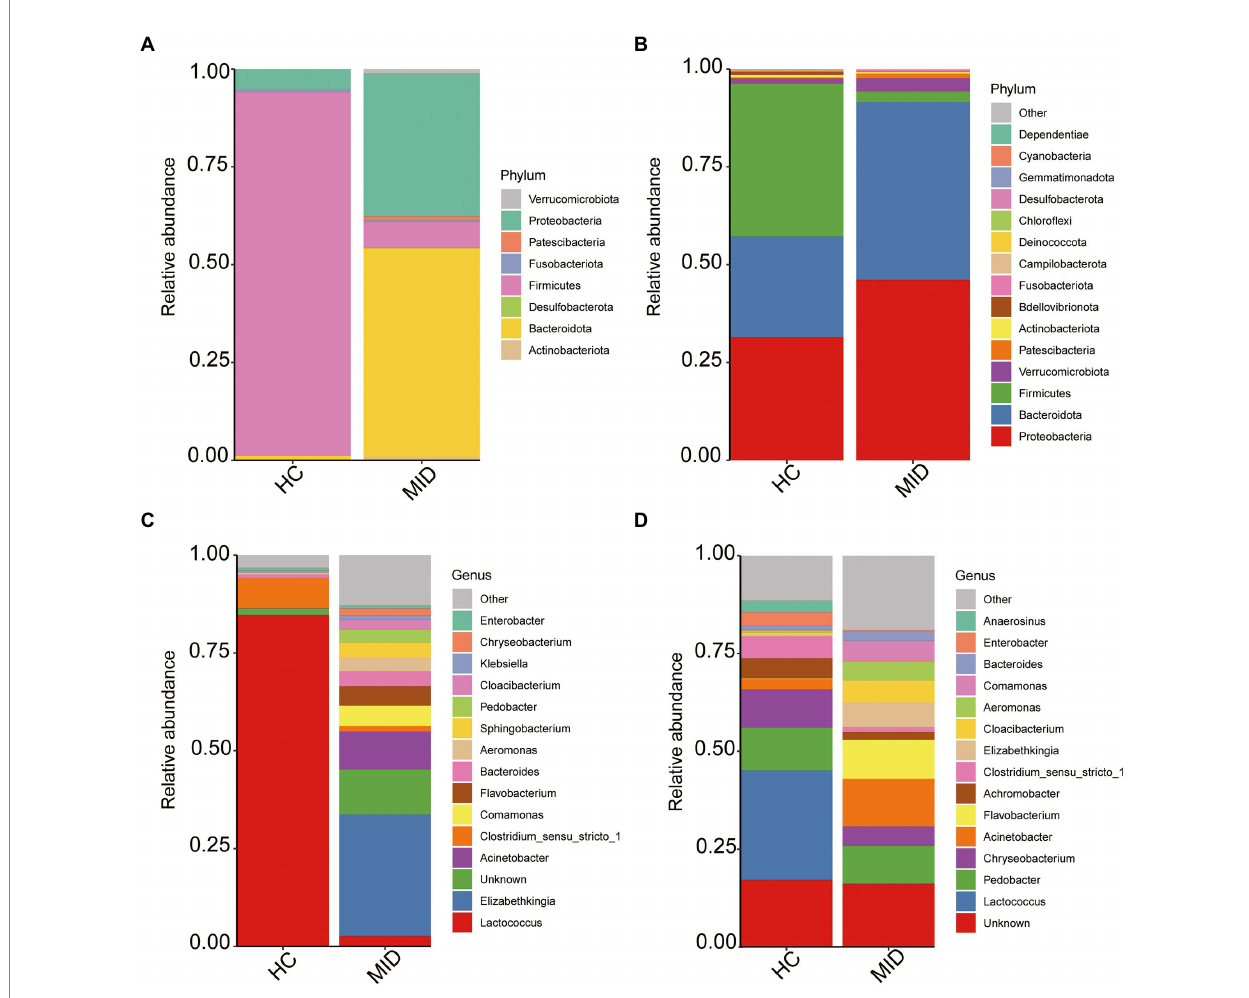
FIGURE 4 Average relative abundance of phylum and gene levels. The top 15 phylum (A,B) , and genus (C,D) , with the highest abundance in each group were presented and the rest were set to